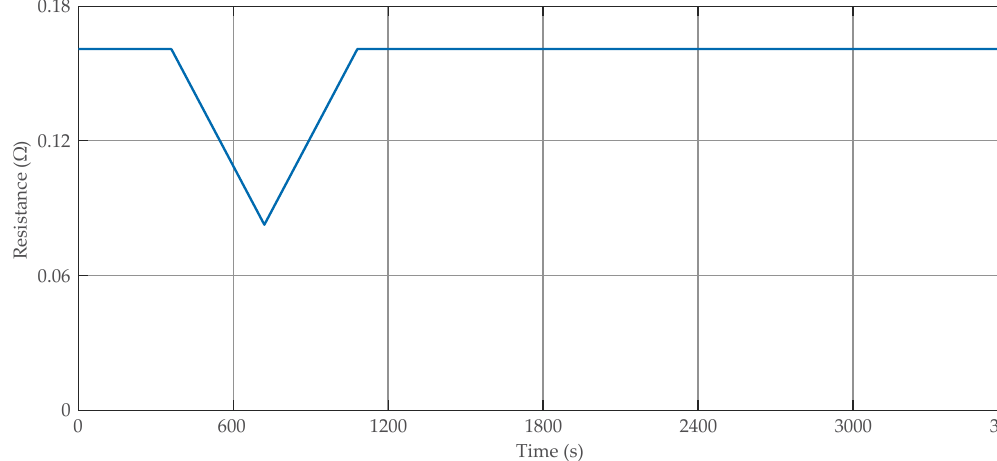
Figure 10. Behaviour of the resistance R 0 for a Li-Po cell according to the V OC and V L identification.